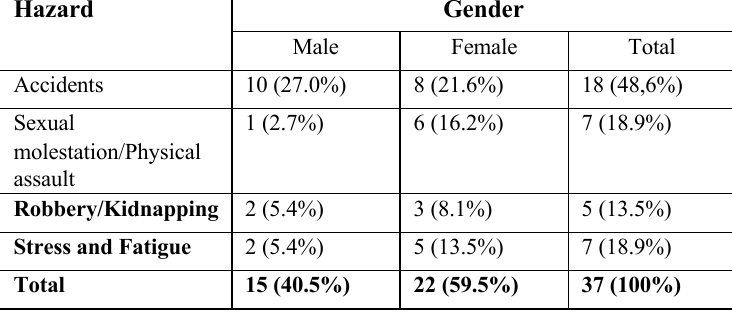
Table 5a. Analysis of hawking hazard on Gender basis Hazard